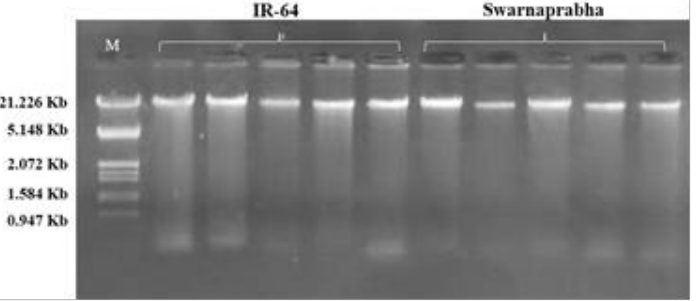
Figure 5. Isolation of genomic DNA from contrasting rice cultivars (IR-64 and Swarnaprabha). Lane M: Lambda DNA/ Eco RI+ Hind III ladder. The concentration of isolated genomic DNA in both sam- ples, IR-64 (5 lanes) and Swarnaprabha (5 lanes), was found to be in a range of 500 – 800 ng/μL.